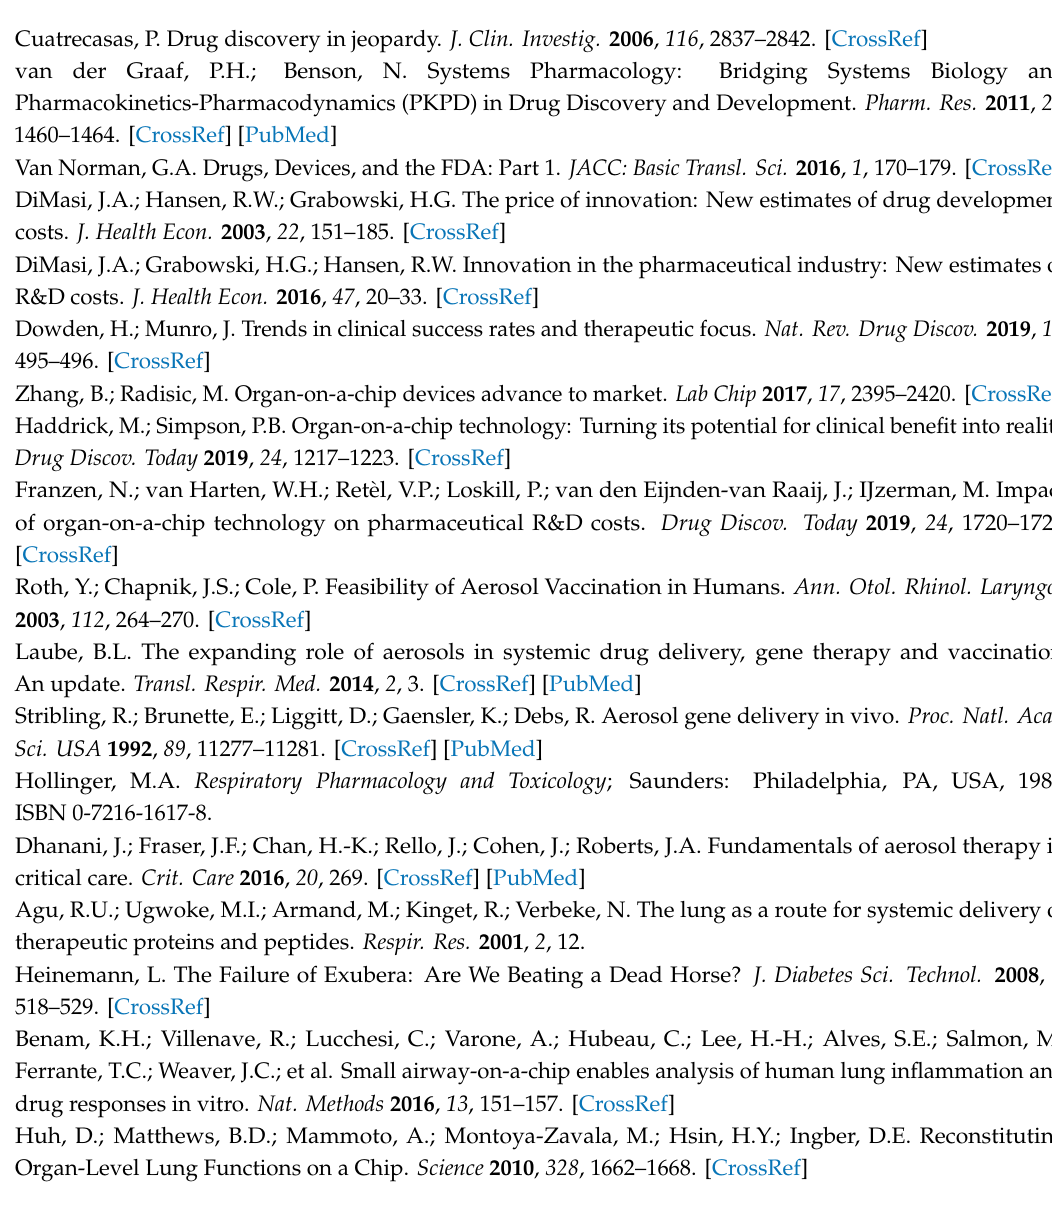
Figure S1: ImageJ generated binary images (obj: × 20) of droplets from: (a) the major aerosol outlet, and (b) in the microchannel. Figure S2: Diameter distribution profiles comparing the Jet major outlet and Jet microdevice. Vertical dashed lines represent the median diameter for each distribution and lognormal PDF’s fit to the data using a least squares method. Figure S3: Bottom channel absorption of fluorescein as a function of time exposed to aerosol. Dashed line represents a best fit approximation of the data. Figure S4: Integral of the bottom channel fluorescent intensity after 10 min of exposure to LMW-Dextran aerosol with membrane pore sizes of 0.8, 3 and 8 µ m (n =